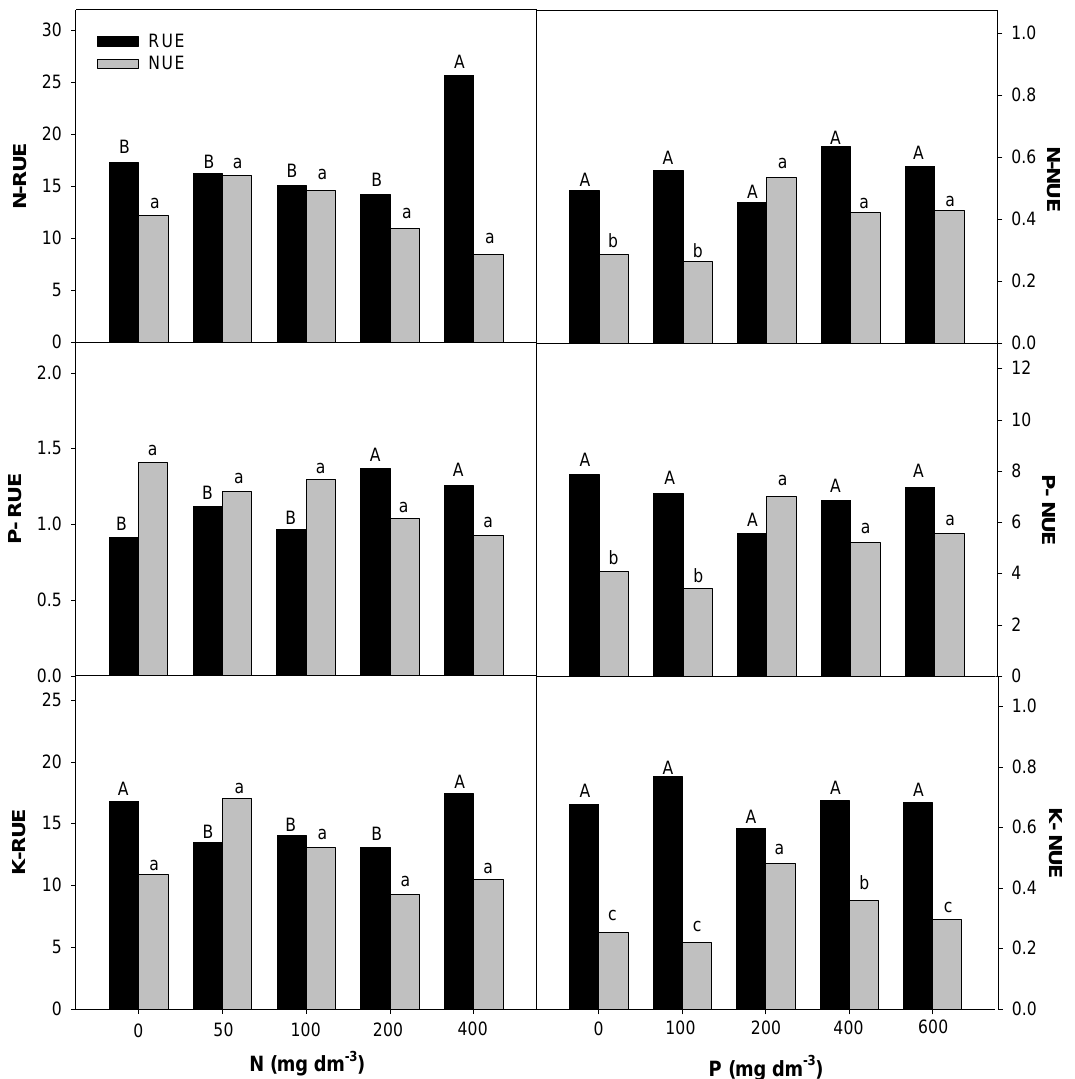
Figure 5. Root uptake e ffi ciency (RUE) and nutrient use e ffi ciency (NUE) for nitrogen (N), phosphorus (P), and potassium (K) in E. dysenterica seedlings. Root uptake e ffi ciency (RUE, mg g − 1 ) and plant nutrient use e ffi ciency (NUE, g 2 mg − 1 ) for the macronutrients N, P, and K in Eugenia dysenterica DC seedlings grown at varying rates of nitrogen and phosphorus for 278 d. Bars represent means ( n = 4). Means followed by the same letters, uppercase for RUE and lowercase for NUE, do not di ff er by the Scott-Knott clustering test ( p > 0.05).